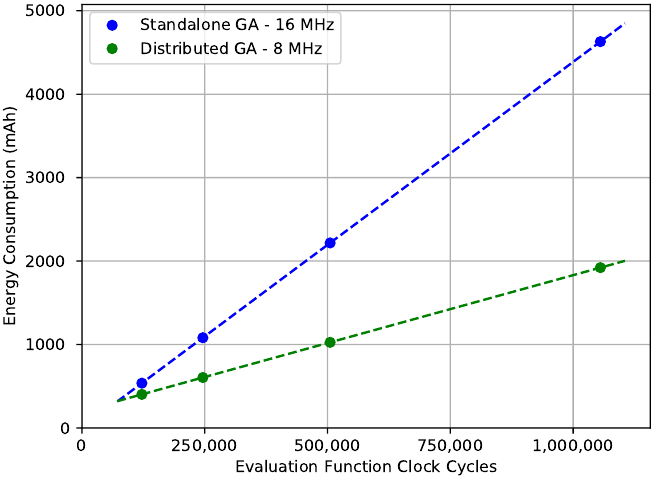
Figure 26. Comparison of standalone GA (1 node) and distributed GA (2 nodes) energy consumption with different clock